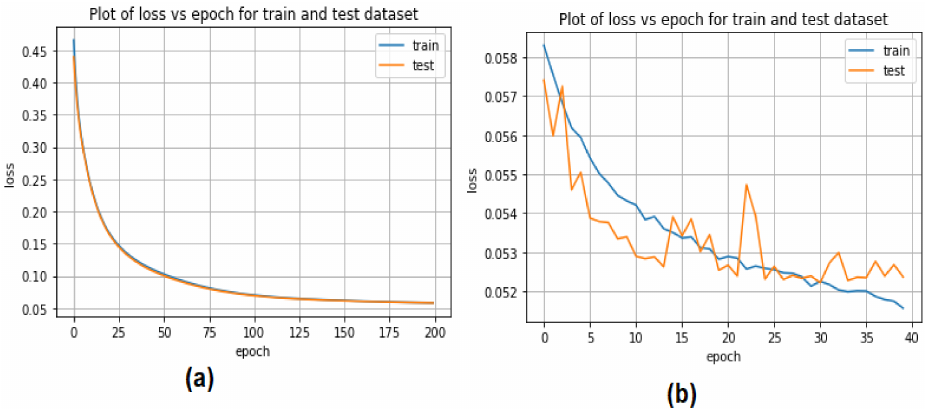
Figure 8. Accuracy loss of deep learning models for binary classification: ( a ) CNN, ( b ) LSTM.